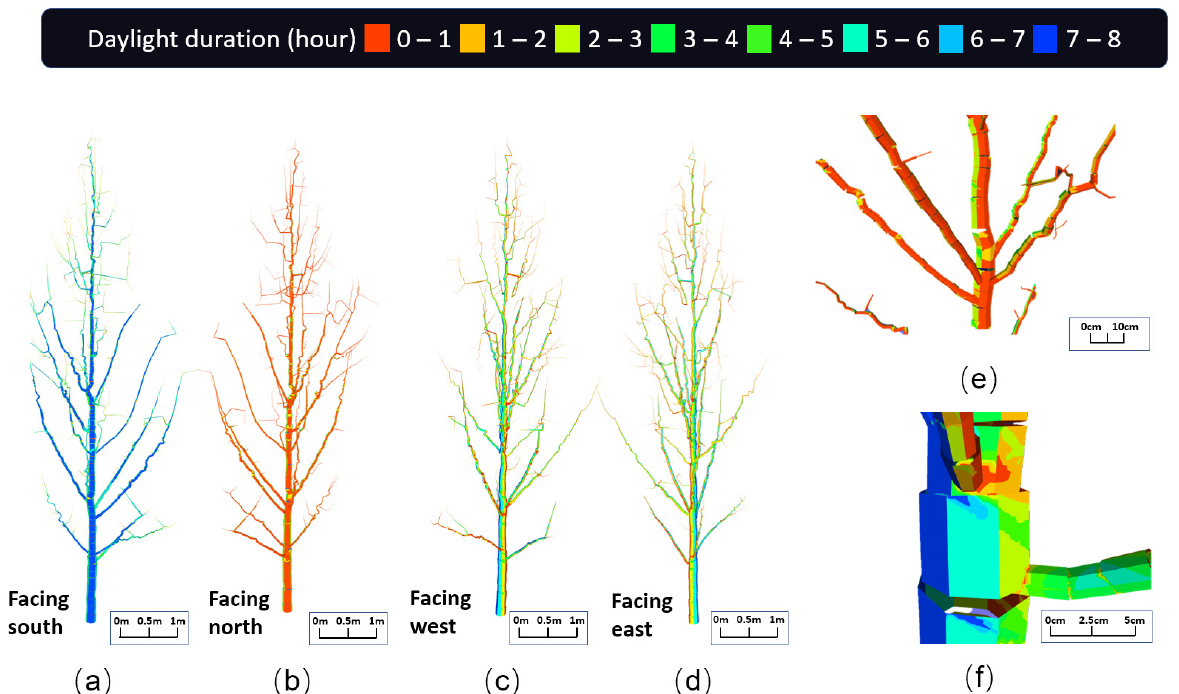
Figure 5. The results of light condition measurement on the single tree QSM model; ( a – d ) views of the result from different directions; ( e ) partial magnified view of the result; ( f ) detailed view on the joint area of the tree model.